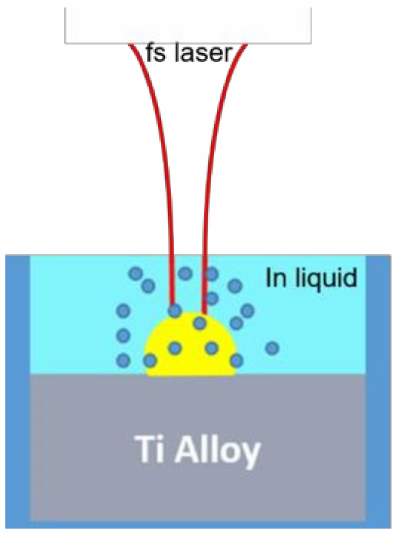
Figure 3. Setup of laser processing AM parts immersed in